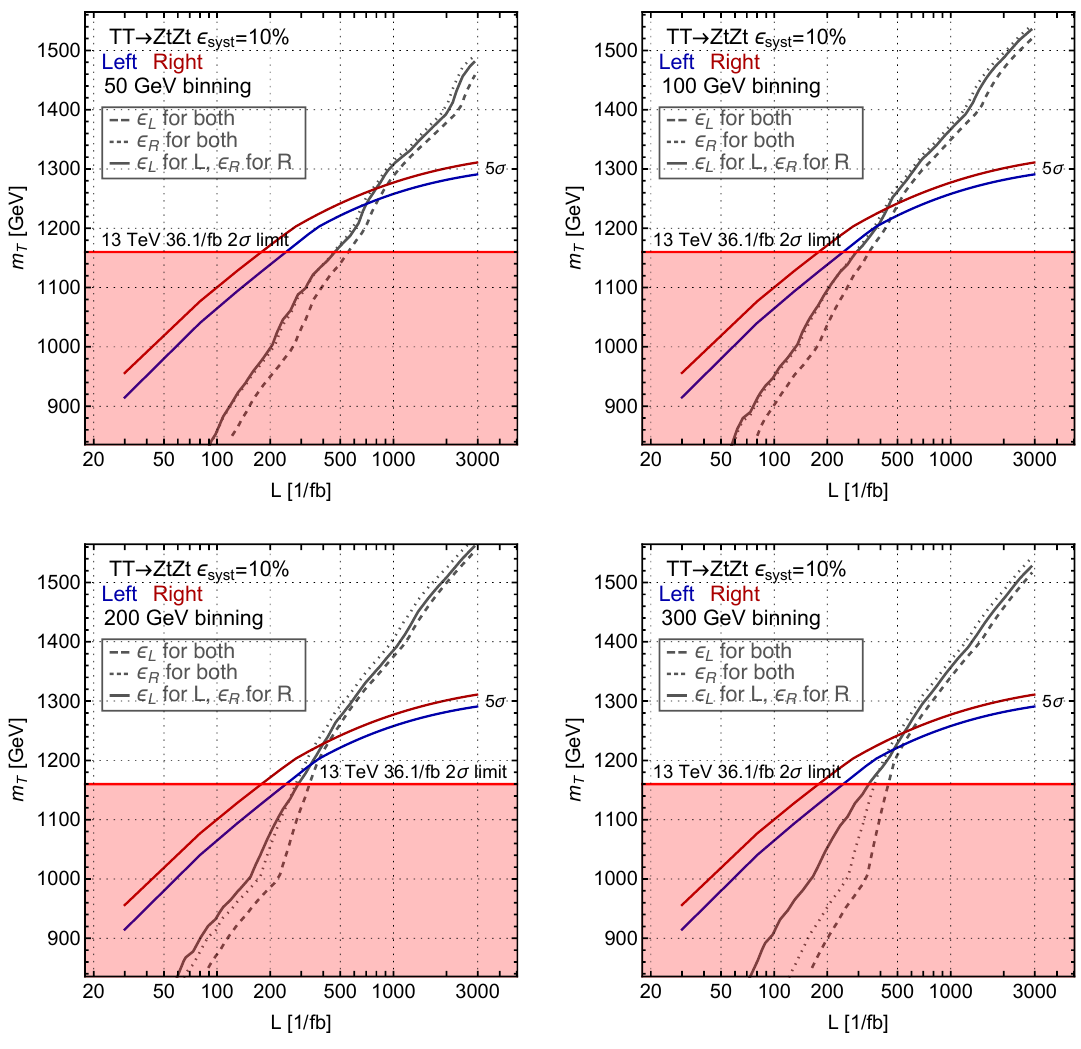
Figure 5 . Projected 5 (cid:27) discovery (blue and red) and 2 (cid:27) discrimination (gray) reach of the ATLAS single lepton search [25] for a T VLQ decaying with 100% branching ratio into the Zt (cid:12)nal state. The blue and red lines correspond to the discovery reach for a the left-handed and right-handed coupling structure assuming an uncertainty on the background determination of 10%. The red shaded area correspond to the present experimental limit from for a VLQ decaying with 100% branching ratio into the Zt (cid:12)nal state, namely 1160 GeV